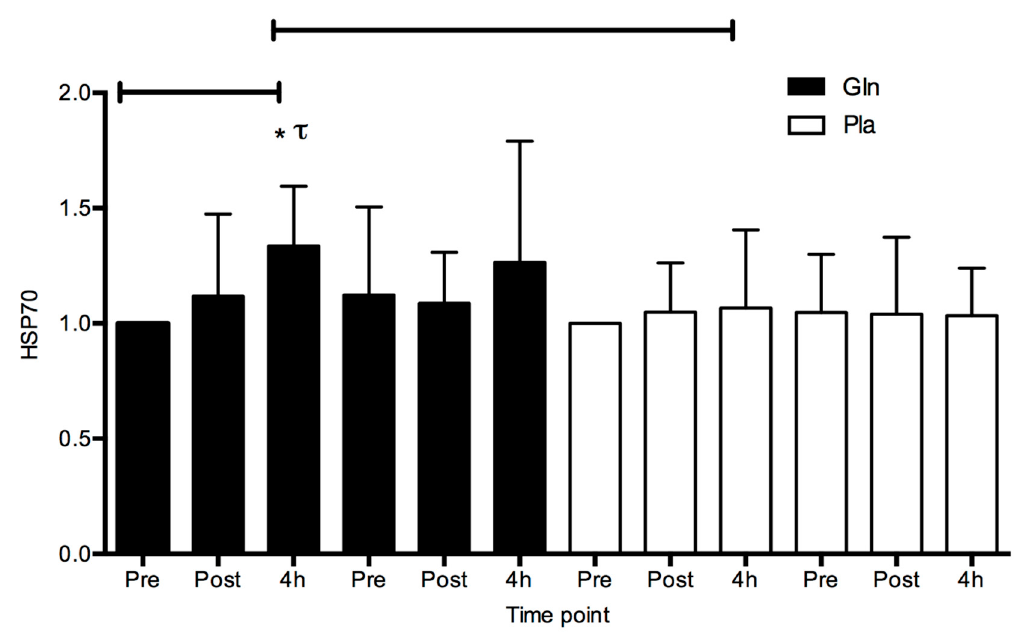
Figure 5. HSP 70 expression. Effect of glutamine supplementation on HSP70 levels in peripheral blood mononuclear cells (PBMCs). Densitometric values of protein content were obtained using a Luminex performance multiplex bead assay, normalized to pre-time points of Day 1 in each trial and set to 1. * p < 0.05, significantly different from the same time point in the placebo trial; τ p < 0.05, significantly different from the pre–exercise level in the same trial. Data are mean ± SD, n = 8.